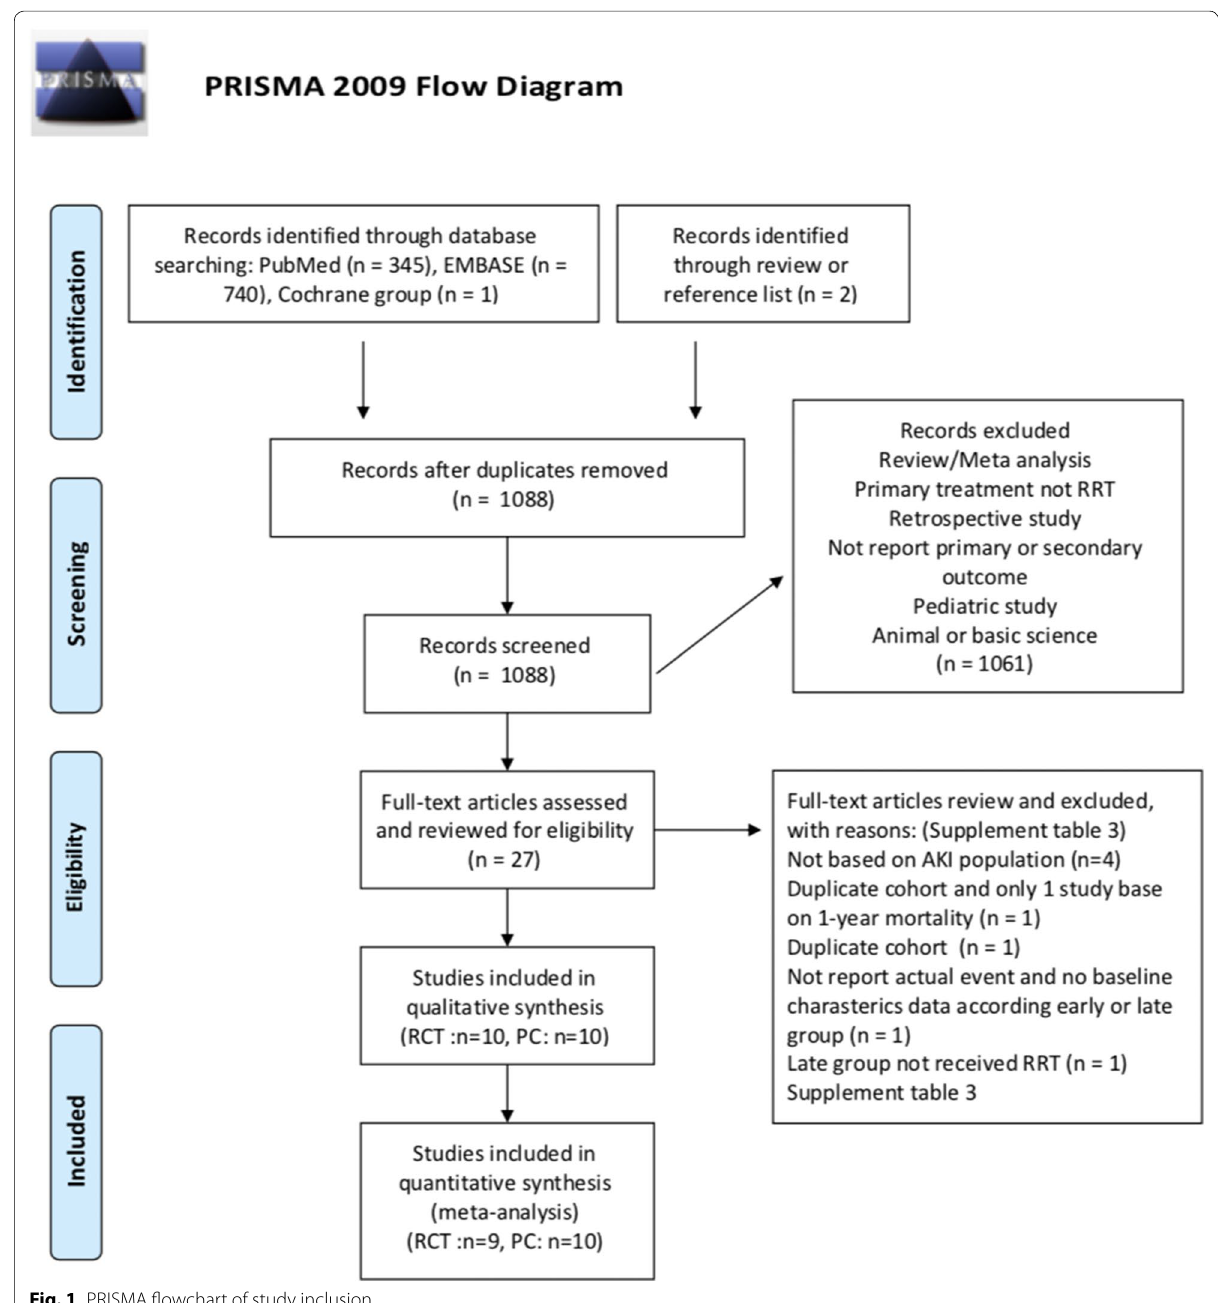
0.49 to 1.11) or renal recovery (OR, 1.40; 95% CI 0.75 to 2.59) (see forest plot of secondary outcomes in Additional file 3: Figure S1). In addition, the results were not altered in the cumulative meta-analysis, except for the result for MV days. The result for MV days was not significant after an outlier study [59] was excluded (data not